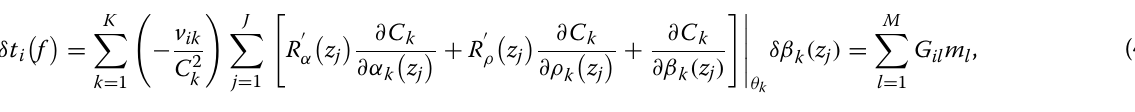
where d , G , and m represent the surface wave travel-time residual vector for all ray paths and discrete frequencies, data sensitivity matrix, and the model parameter vec- tor, respectively. The damping and weighting parameters were applied to balance data fitting and smoothing regu- larization. These inversion parameters were selected on a trial-and-error basis for our data considering the diverse patterns in inverted S-wave velocity models (weakly smoothed and strongly smoothed S-wave velocity mod- els are shown in Additional file 1: Figures S1 and S2, respectively). We conducted two inversions with coarser and finer grid intervals between grid points in each horizontal direction for the entire Kinki region and the northern part of the Kinki region (with dense distribution of seis- mic stations), respectively. The entire Kinki region was parameterized into 53 by 58 grid points on the horizon- tal plane with 0.055° intervals between grid points in each horizontal direction, whereas the northern part was parameterized into 27 by 75 grid points on the horizon- tal plane with 0.025° grid point intervals in the latitude and longitude directions. For both inversions, we used 9 grid points along the depth direction (i.e., 0, 0.6, 1.2, 2, 4, 6, 9, 12 and 16 km) and used dispersion data within a frequency bandwidth of 0.0714–1.0 Hz. Empirically, the fundamental mode Rayleigh wave phase velocity is pri- marily sensitive to 1.1 S-wave velocity at a depth of × about 1/3 multiplied by its corresponding wavelength (λ) (Fang et al. 2015; Foti et al. 2014; Hayashi 2008). Conse-